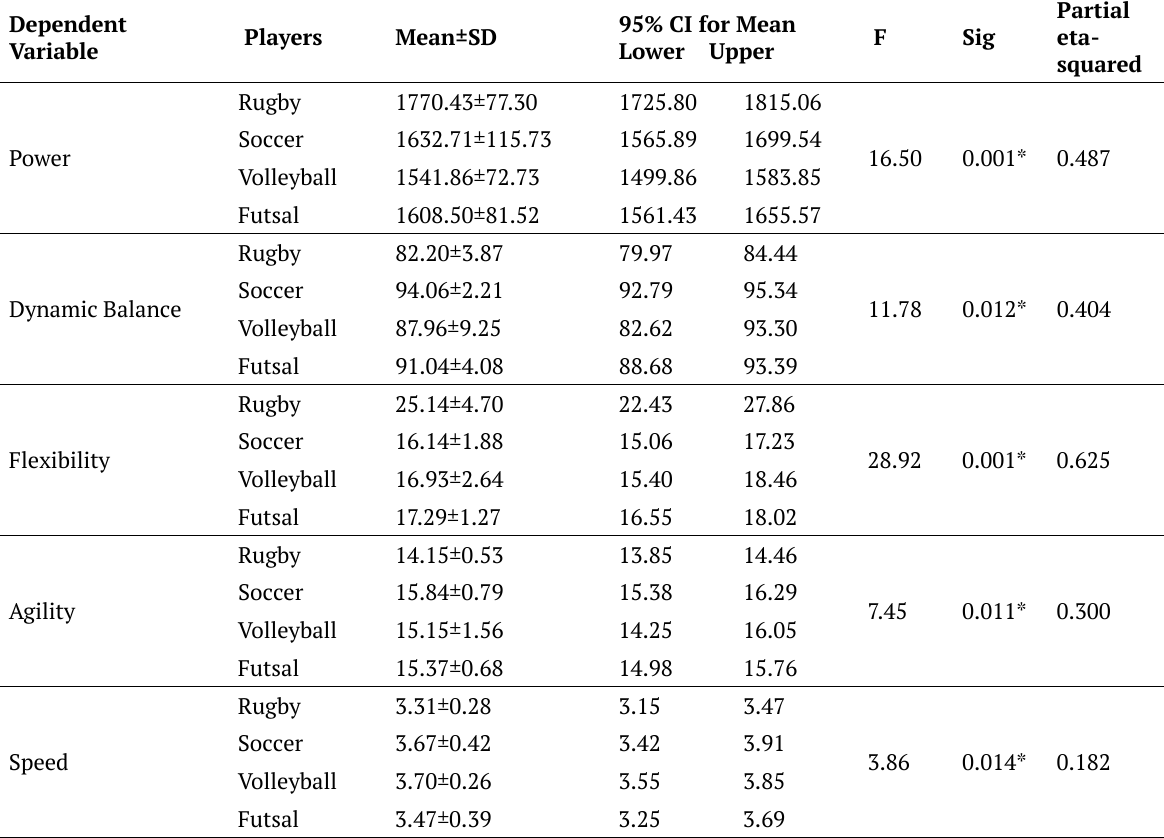
Table 4. Comparison of Physical Performance Measures among Athletes from Random Intermittent Dynamic Type Sports.